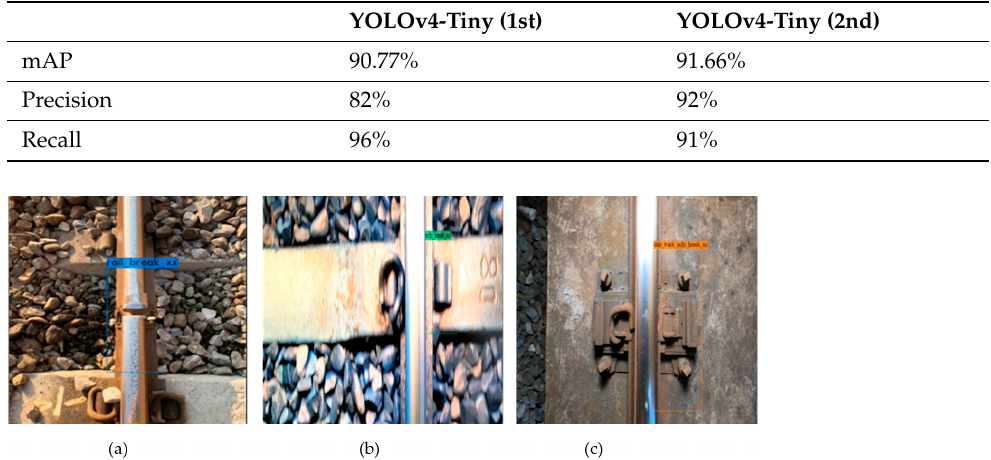
Figure 10. Examples of the detected defective track components in the top view. ( a ) rail surface_XX; Table 8. Performance of the 1st and the 2nd version of YOLOv4 ‐ Tiny. ( b ) e_Clip XX; ( c ) slab e_Clip